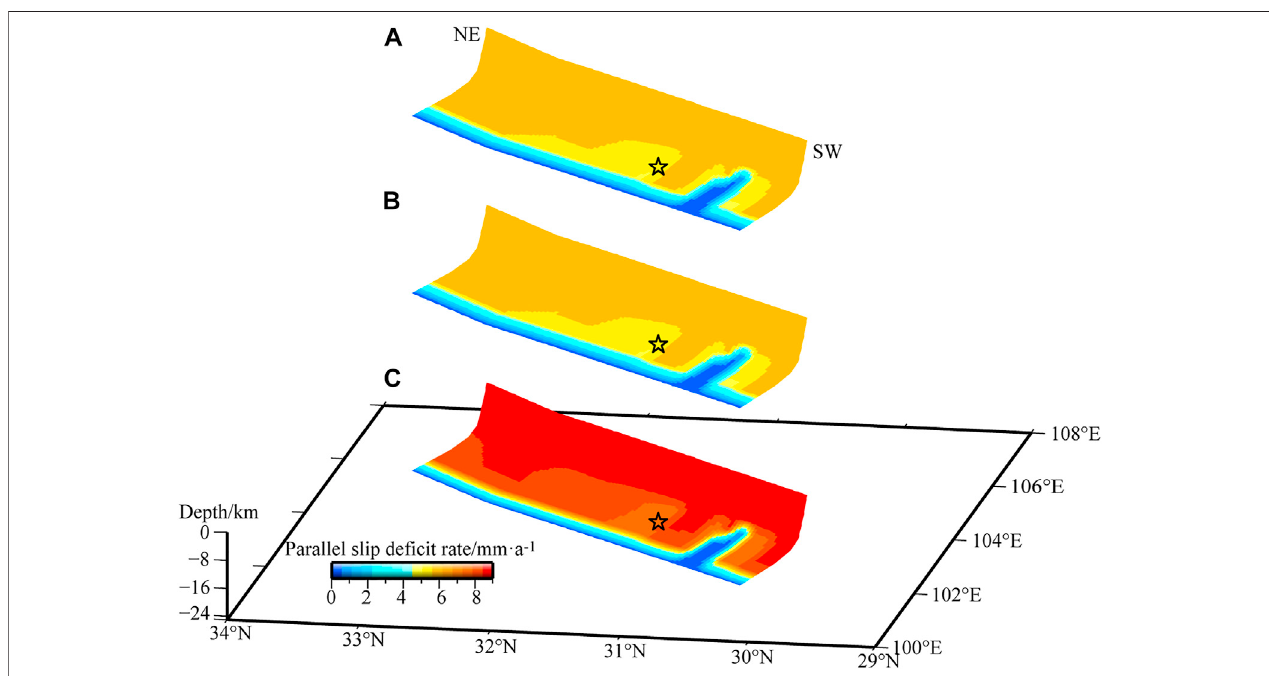
FIGURE4| Spatialdistributionoffault-parallelslipde fi citratesduring (A) 1999 – 2001, (B) 2001 – 2004,and (C) 2004 – 2007alongtheLongmenshanfaultplane.The black star denotes the Wenchuan earthquake source location.